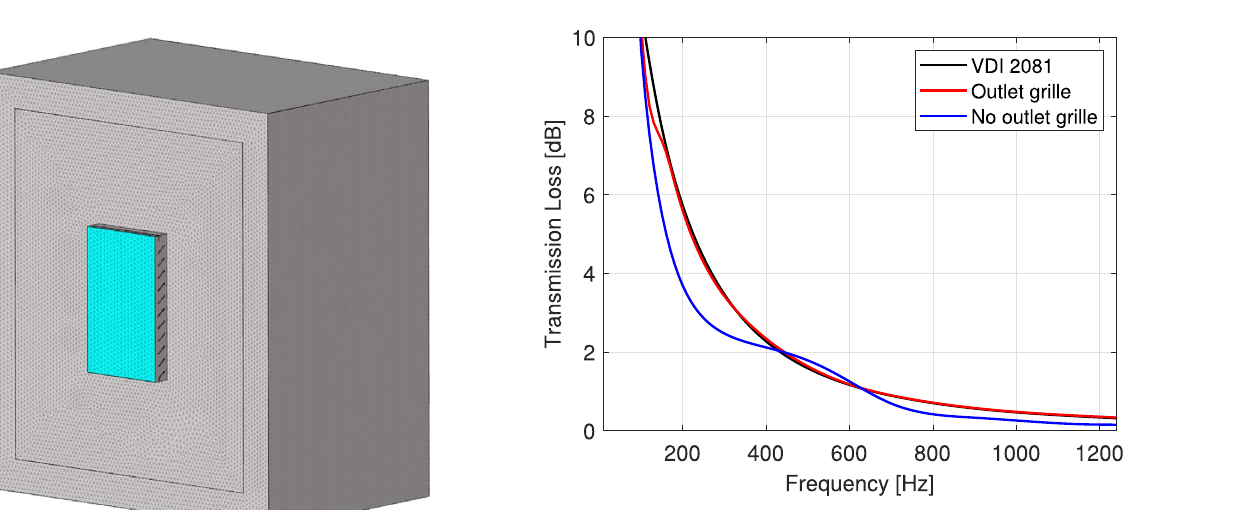
Figure 6. Transmission loss of a terminal